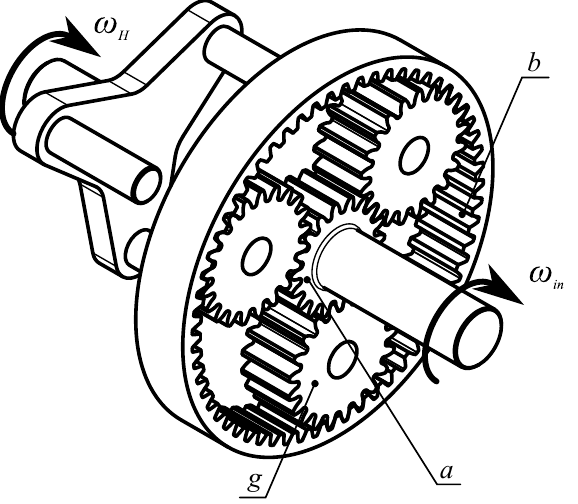
Figure 1. 3D illustration of the planetary gearbox considered in this paper.